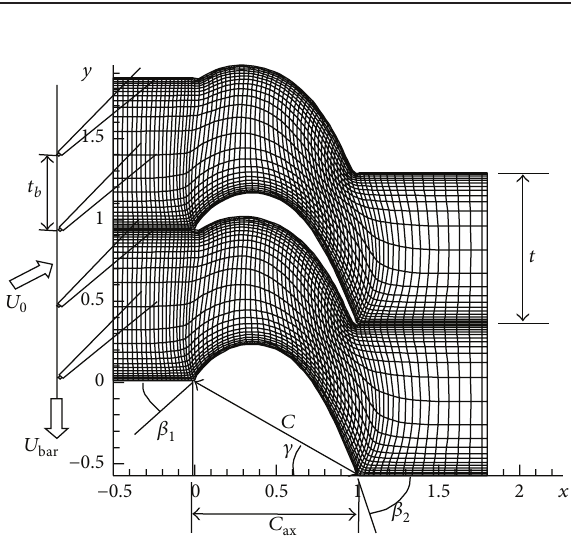
Figure 1: Flow configuration and grid for LES at Re = 5.18 × 10 4 (every 6th grid line is shown in both stream-wise and pitch-wise